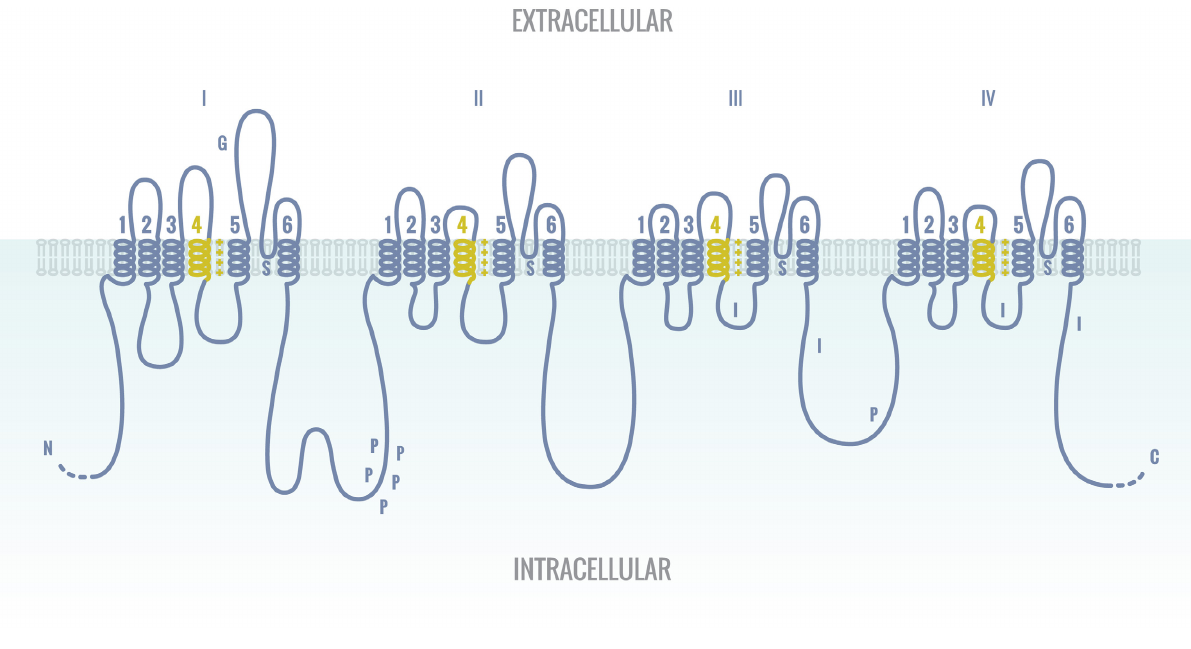
trans-membrane sequences. G, glycosylation; P, phosphorylation; S, ion selectivity; I, inactivation sites. Positive ( + ) charges in S4 are crucial for transmembrane voltage